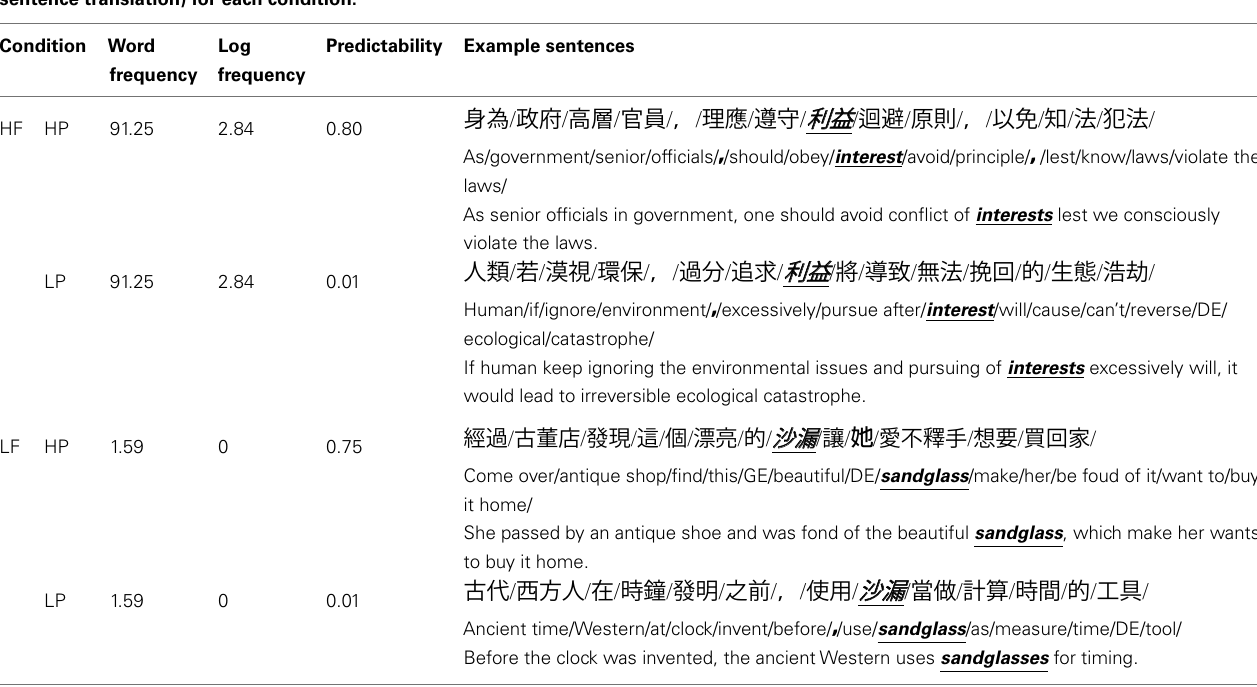
Table 1 | Means of word frequency and predictability of target words and example sentences (Chinese, word-by-word translation, and whole sentence translation) for each